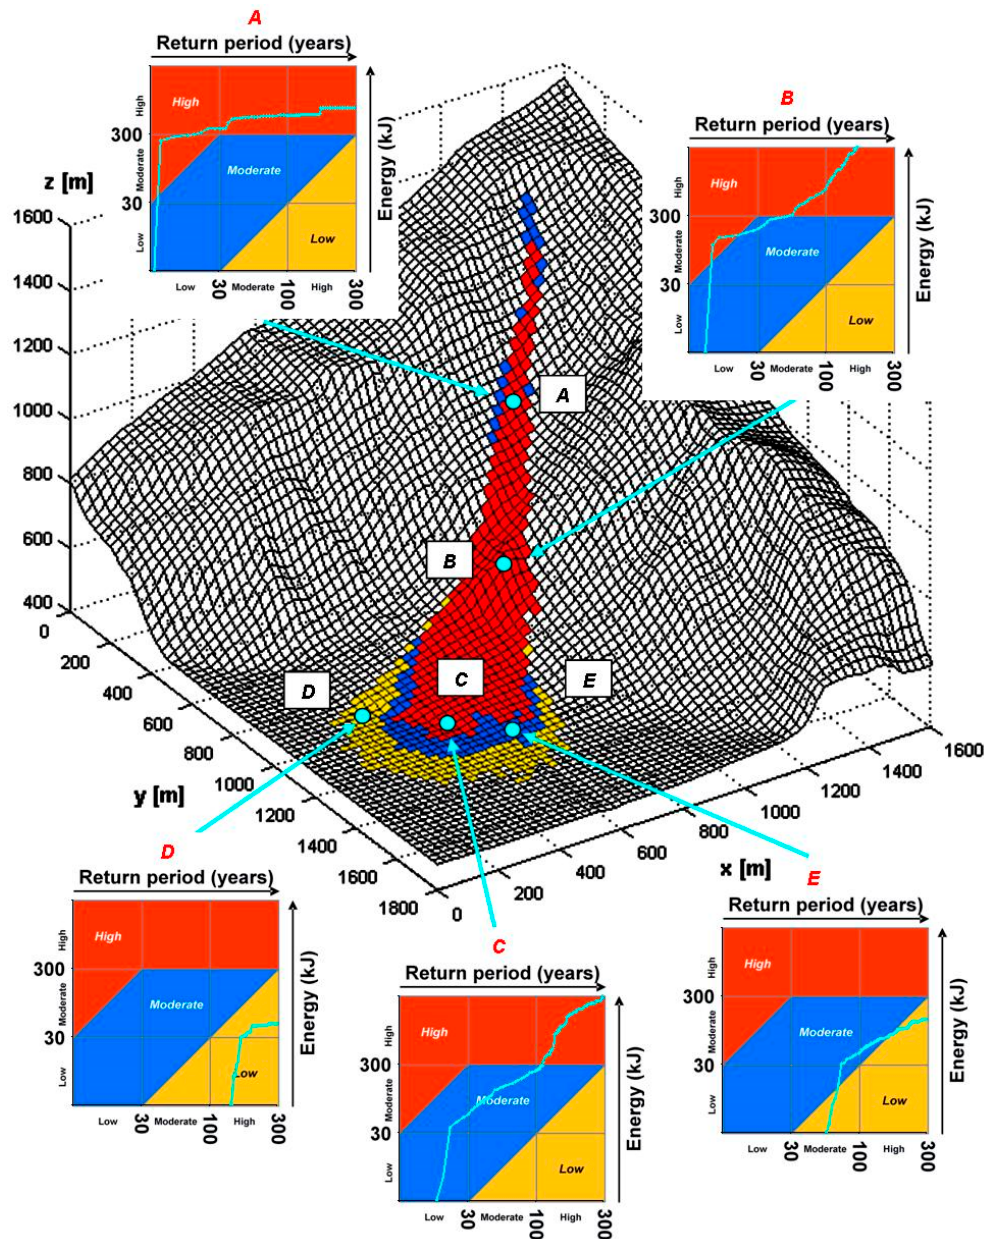
Figure 13. Hazard zoning at Les Crêtaux, performed for a single source scenario characterised by a failure frequency λ f, 2 D = 0.04 (years − 1 · m − 2 ) (i.e., λ f,cell = 25 years − 1 ). The figure also shows the spatial evolution of hazard over the slope, at different points A, B, C, D and E, located at increasing distances from the source area.